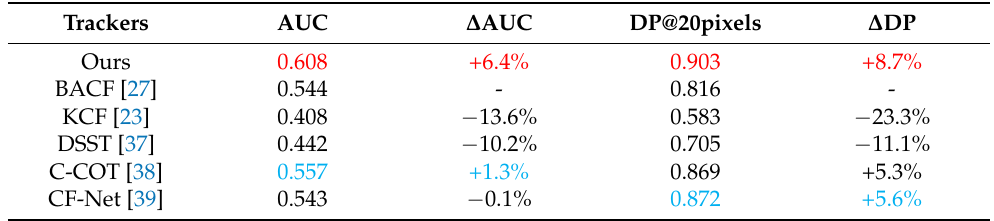
Table 4. Tracking performance comparison with RGB object trackers. The best two results are marked with red and